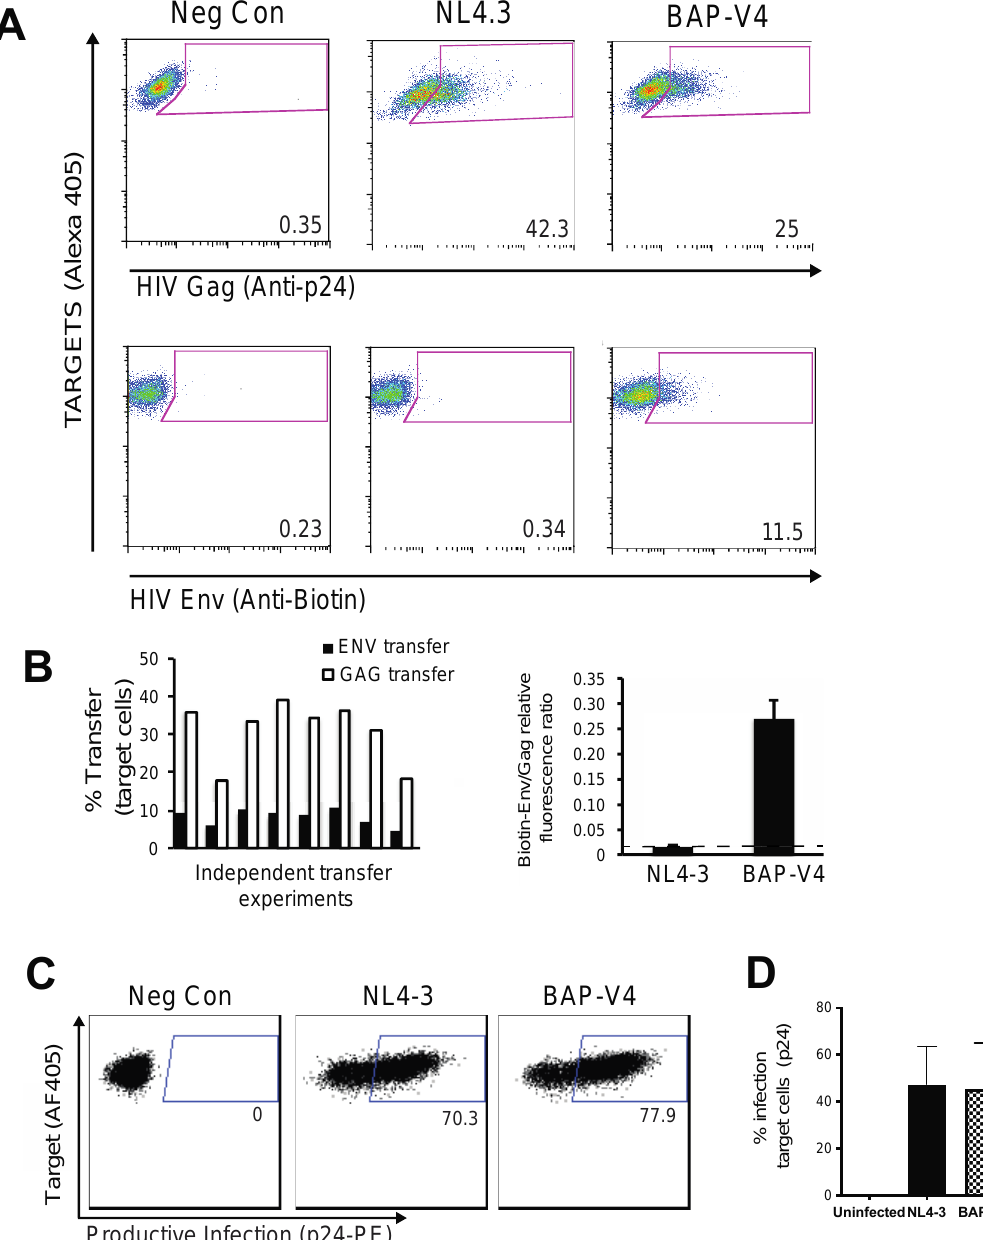
Figure 2. HIV Env BAP-V4 with a biotinylated envelope mediates infectious cell–cell transfer and transmission. Jurkat cells were nucleofected with WT, or BAP-V4 with BirA. All populations were then incubated at 37 °C with anti-biotin-647, washed and used as infected donor cells in 4 h cell–cell transfer assays with uninfected primary CD4 T cells. The levels of HIV transfer were measured by intracellular p24 staining. ( A ) Representative FACS plots show the level of HIV Gag (anti-p24) (top row) and Env (anti-biotin) (bottom row) transfer into primary CD4+ cells. ( B ) Graph on the left represents eight independent transfer experiments showing the Env and Gag transfer into primary CD4 T cells after cell–cell transfer assays as measured by anti-biotin and p24 intracellular staining. Graph on right is the cumulative mean ratio of biotinylated Env/Gag transferred into target cells using WT NL4-3 or BAP-V4 across all eight experiments. NL4-3 Env transfer level (which is not biotin labeled) represents background fluorescence measured in this assay. ( C ) Flow cytometry plots showing the level of virus infection measured by intracellular p24 staining (productive infection) in primary activated CD4 T cells 48 h after co-culture with uninfected (left panel), NL4-3 (middle panel)- or BAP-V4 (right panel)-infected cells. AZT was added 6 h post-co-culture in cell–cell transfer assay to limit the infection to a single round. ( D ) Graph shows the SEM levels of productive infection at 48 h after cell-to-cell infection, from n = 3